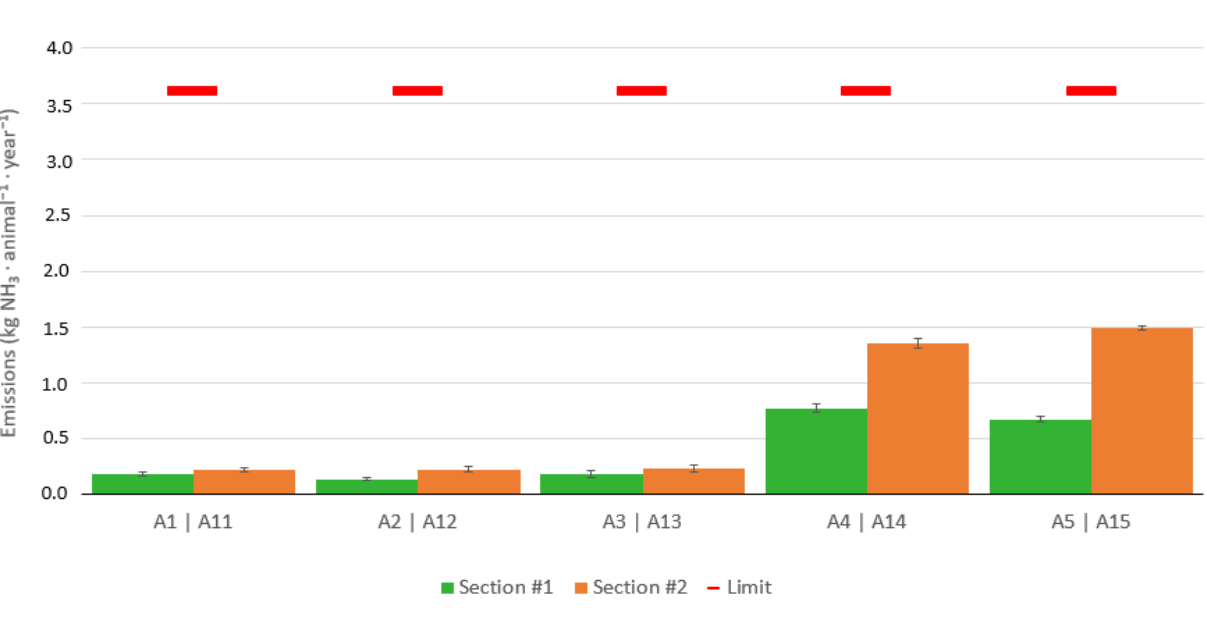
Figure 1. NH 3 emissions between February and June in 1st breeding cycle.